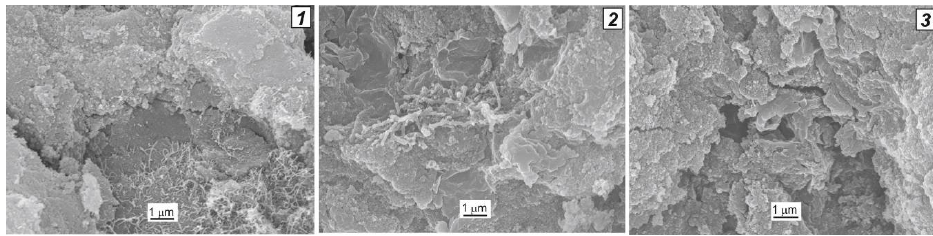
Figure 5. SEM images of cleavages of the biocatalysts prepared by immuring baker yeast autolysates inside nanocarbons-in-silica composites: 1— CNT1s, 2 —CNFs, 3 —CNSs. Smooth areas corresponded to entrapped autolysates.